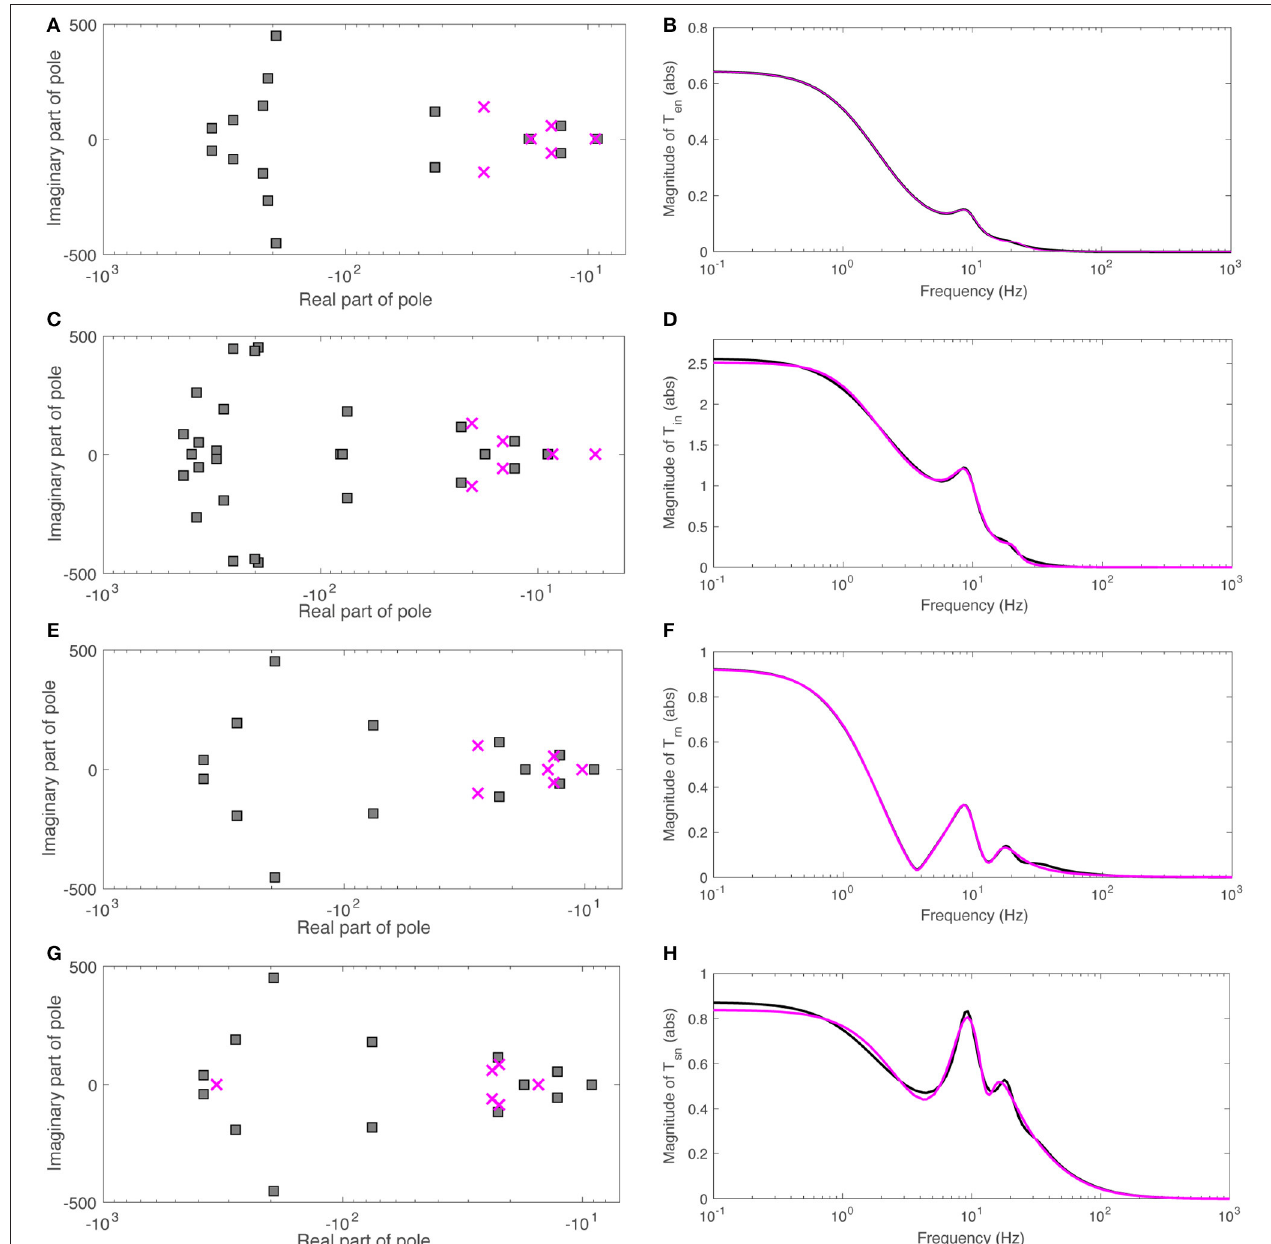
FIGURE 5 | Poles and magnitudes of rational approximations to the transfer functions T an . (A) Poles of 16-pole (black squares) and 6-pole (red crosses) approximations of T en . (B) Magnitude of 16-pole (black) and 6-pole approximations of T en vs. frequency. (C) Same as (A) for T in . (D) Same as (B) for T in . (E) Same as (A) for T rn . (F) Same as (B) for T rn . (G) Same as (A) for T sn . (H) Same as (B) for T sn .